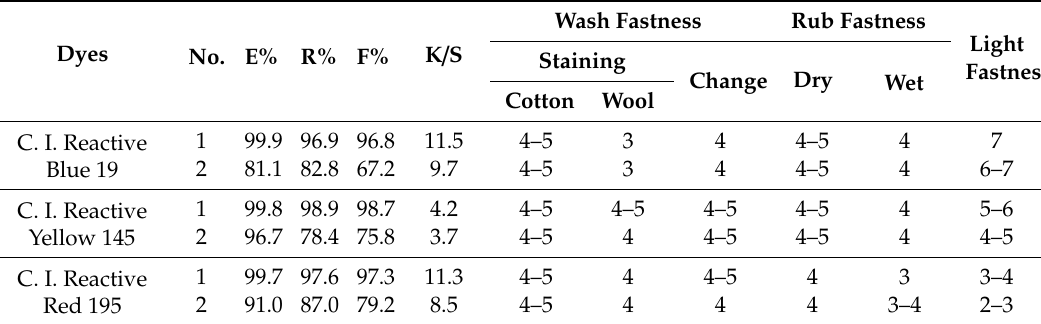
Figure 4. Dyeing samples of C. I. Reactive Blue 19, C. I. Reactive Yellow 145 and C. I. Reactive Red 195 on original and modified cotton fabrics: ( a – c ) on original cotton with the conventional dyeing method, ( d – f ) on modified cotton with the salt-free dyeing method. Table 2. Dyeing properties of DMC-modified and original cotton